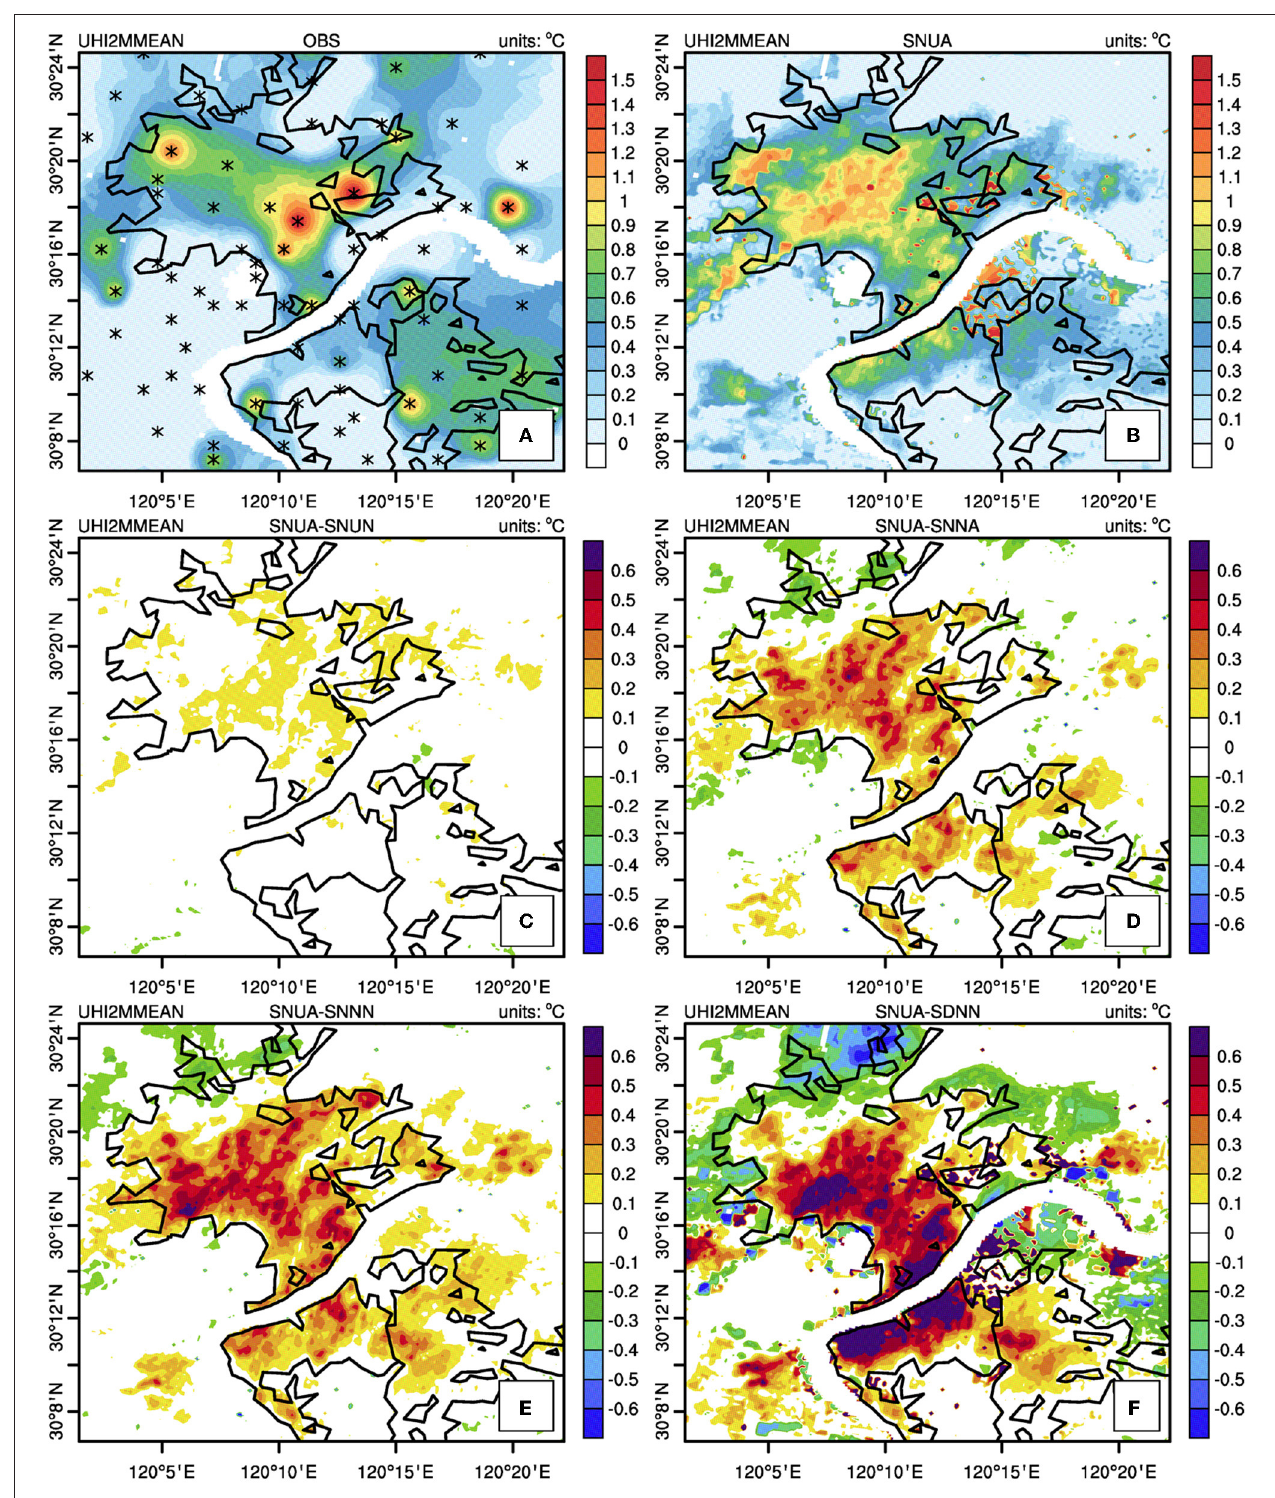
FIGURE 10 | The (A) observed and simulated urban heat island (UHI) derived from (B) SNUA run and the difference of UHI between SNUA run and (C) SNUN, (D) SNNA, (E) SNNN, and (F) SDNN runs.